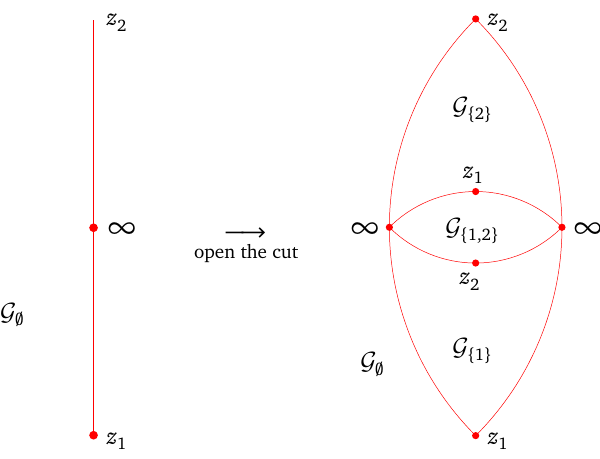
Figure 9: Representation of the surface corresponding to the Riemann surface R The sheet G (cid:59) is represented on the left, with a cut linking the points [ z and [ ∞ , G (cid:59) ] . Opening the cut, all the other sheets G { opening. The graph made by the cuts of all sheets is planar, and R the Riemann sphere (cid:98) (cid:67)